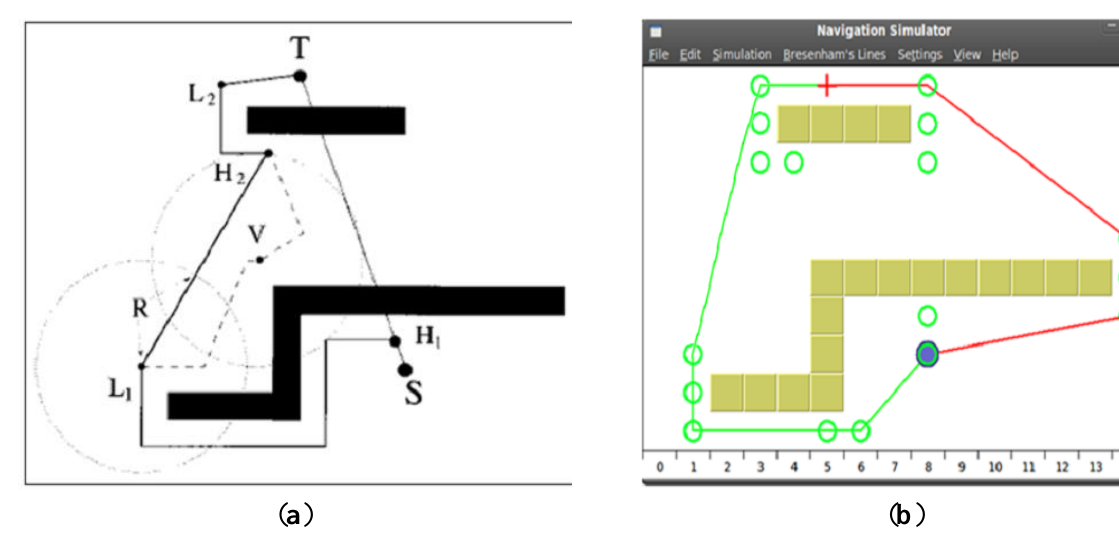
Figure 11. Navigation results of DistBug and HCTNav . HCTNav would find a shortest path to the right of the obstacles (red line). ( a ) DistBug‟s theoretical solution; ( b ) HCTNav ‟s